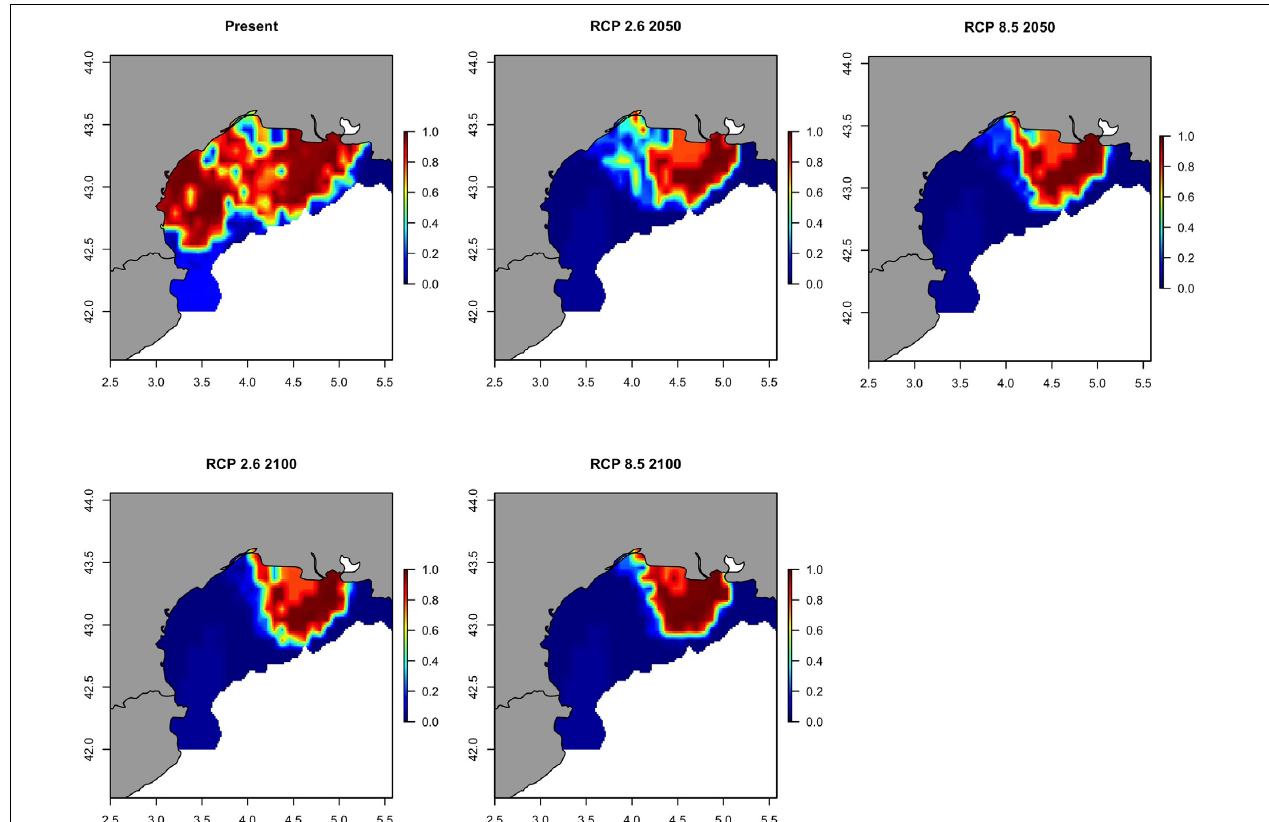
FIGURE 14 | Predicted probability of occurrence of the European anchovy ( Engraulis encrasicolus ) in Geographical Sub-Area 07 for the present situation and using IPCC pathway scenarios obtained with RAC-BRT